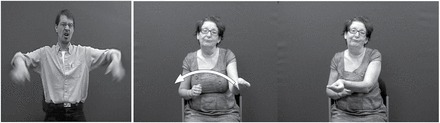
(a) Constructed action. The signer’s body represents the body of a bear (Woll et al., 2004). (b) Handling construction. The signer’s hand represents the hand of a referent moving a flat object rightward (photo originally published in Cormier et al., 2012).